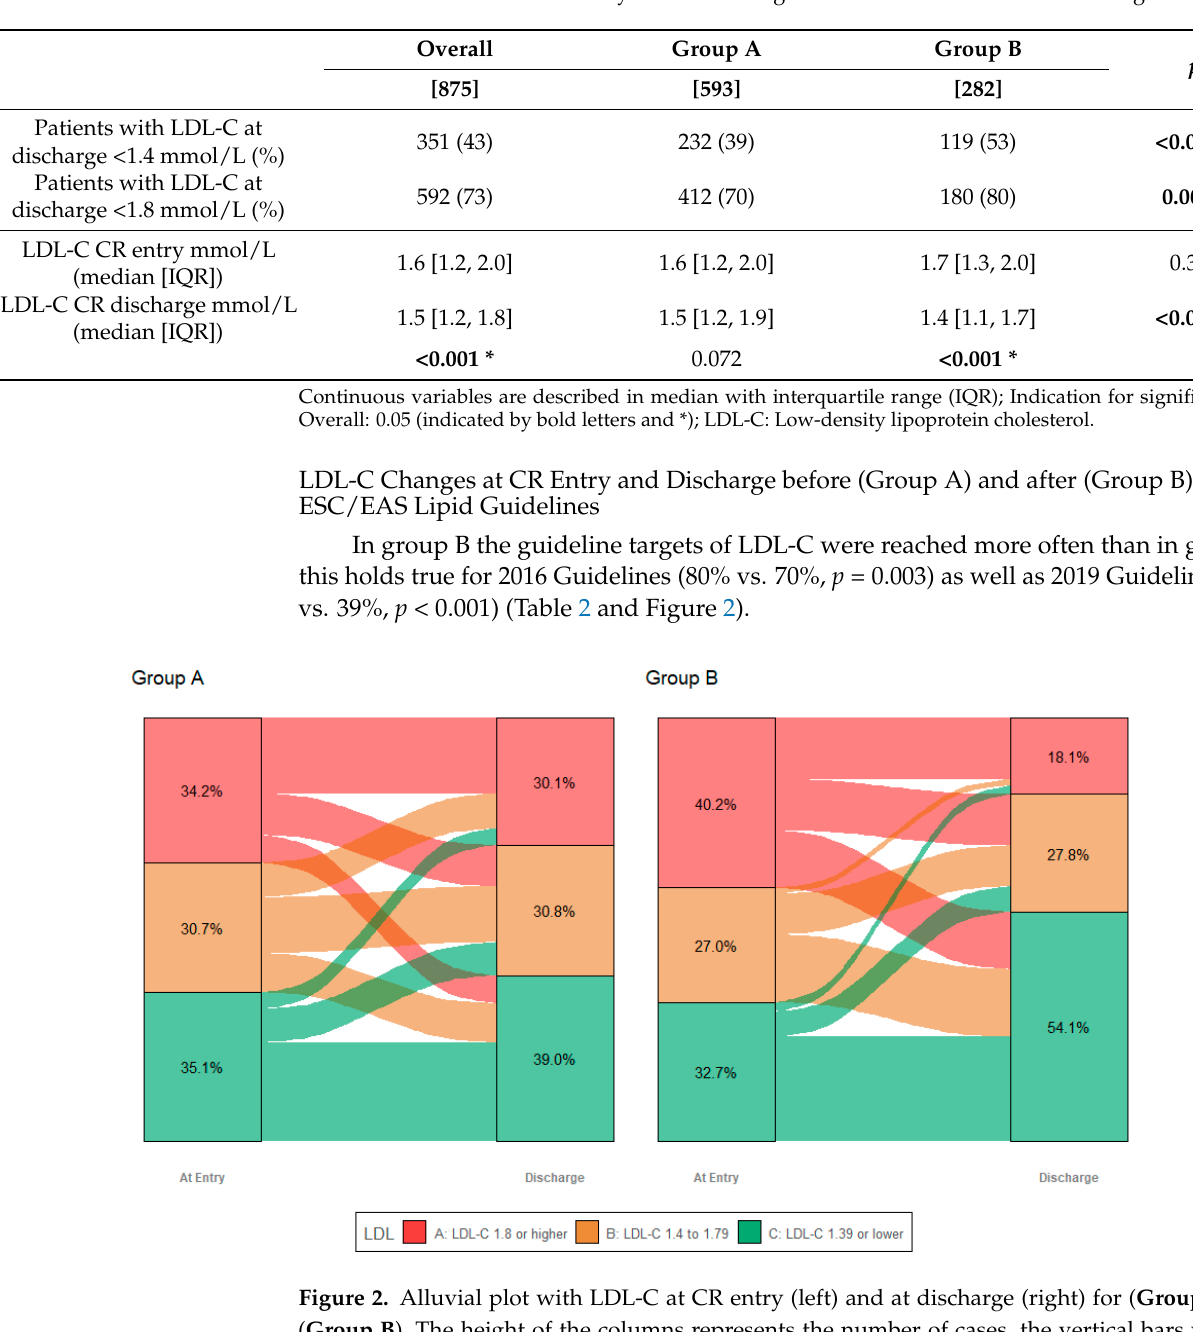
Table 2. LDL-C levels at CR entry and at discharge overall and stratified after discharge time period.